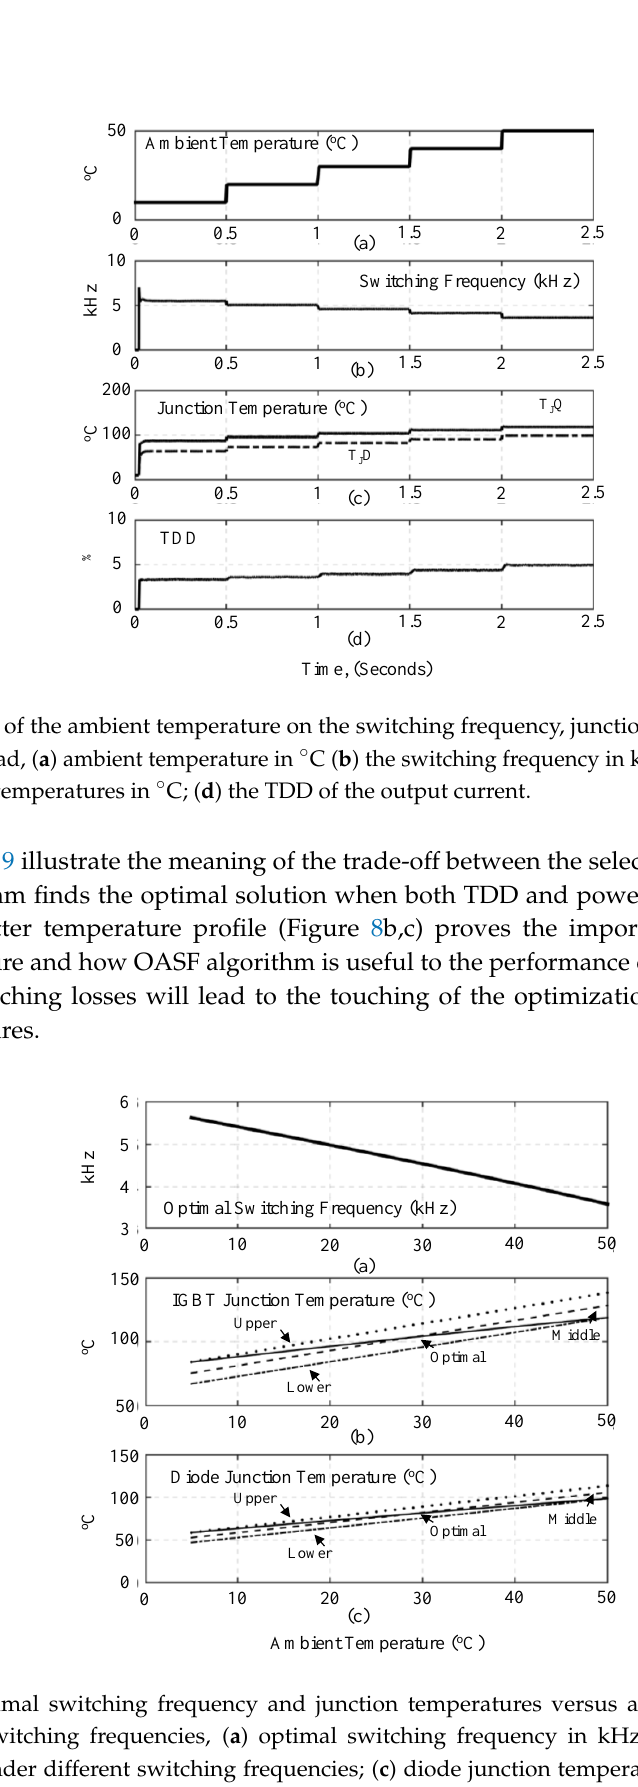
Figure 9. TDD versus the ambient temperature for different switching frequencies. 5. Optimal Selection of Weighting Factor and Experimental Validation Selecting the weighting factor of the objective function can be considered as an additional degree of freedom of the proposed algorithm. The weighting factor is selected to attain the lowest cost of the heat-sink and the filter. As discussed in the previous part, the minimum switching frequency occurs at maximum output power and maximum ambient temperature. Therefore, the filter should be designed at the minimum optimal switching frequency. Moreover, the cooling system must be designed at this point, because the maximum junction temperature is linked to the same loading